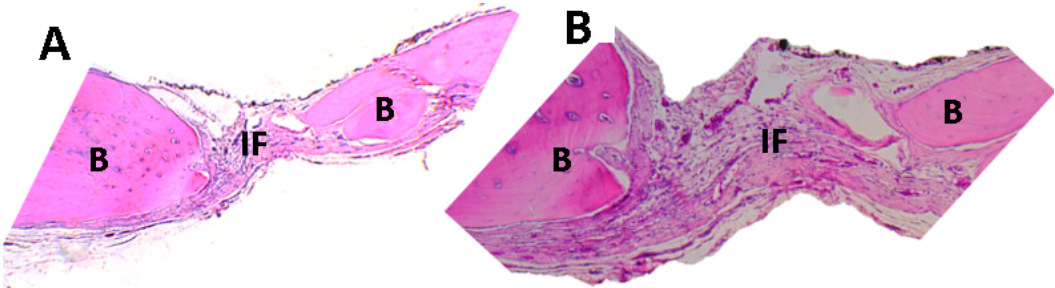
Figure 1. Control site (empty defect). Image ( A ) at 5 × image ( B ) at 10 × preparation zone. ( B ): peripheral bone, FI: a fibrous interface. Hematoxylin-eosin (HE) stain was used for the analysis of the preparation area.